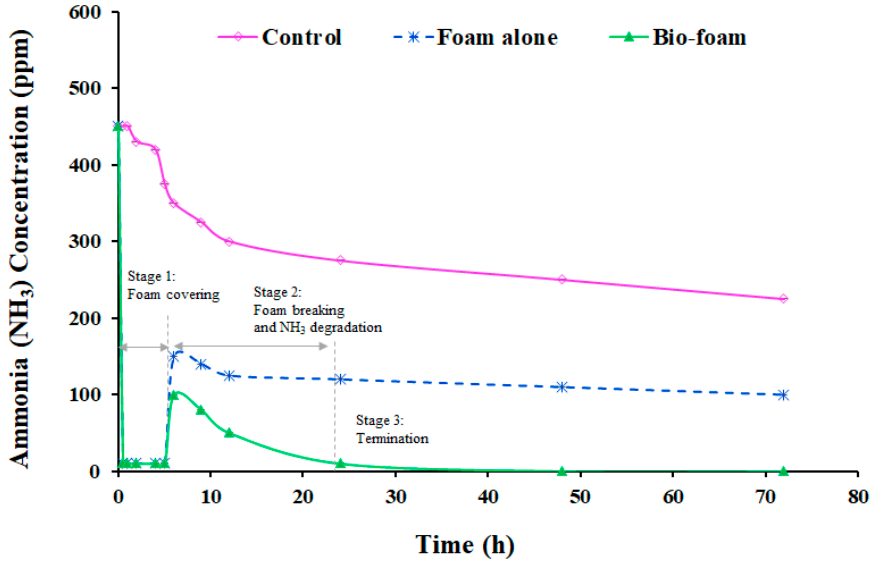
Figure 4. Change in NH 3 concentration emitted from swine manure in the open reactor: control (no treatment, only manure), foam alone (application of surfactant foam only), and bio foam (surfactant foam containing bacteria). The initial NH 3 concentration in the manure was 450 ppm.